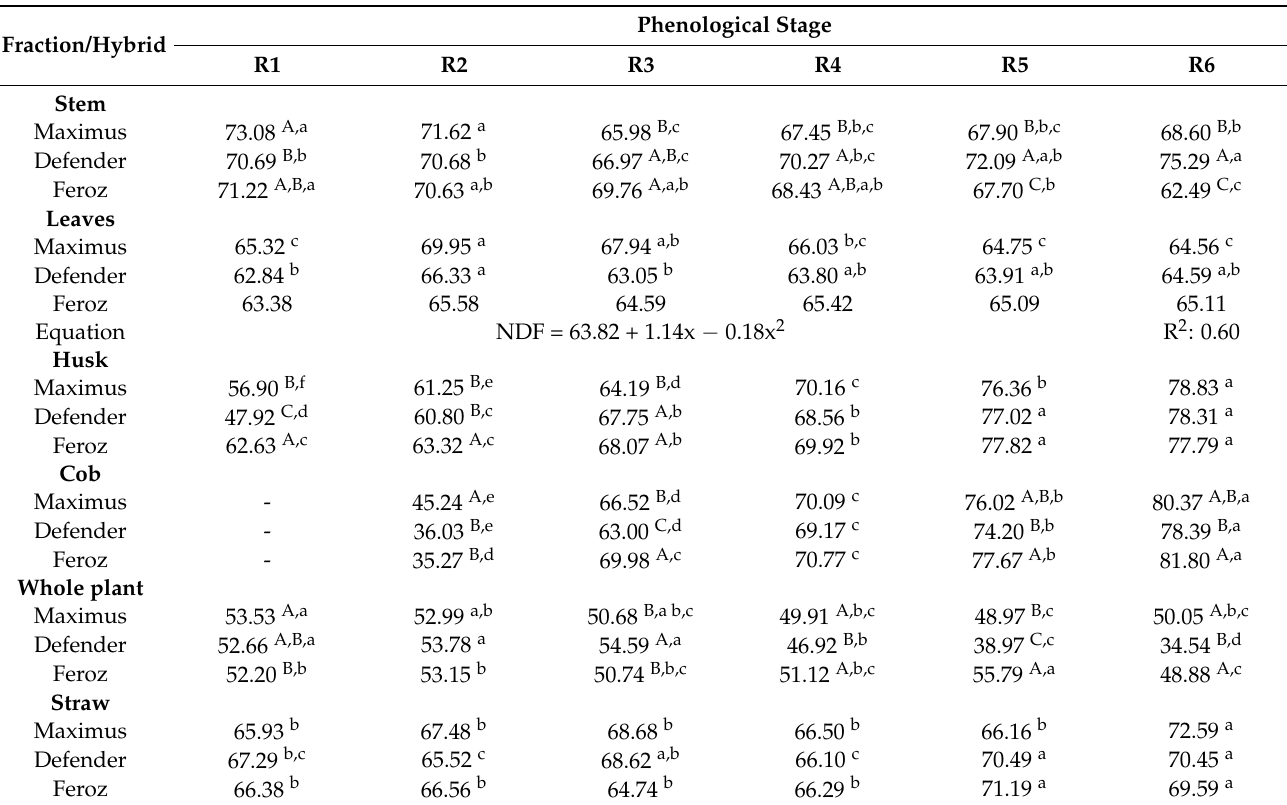
Table 3. Neutral detergent fiber (% DM) of the whole plant and the fractions of three maize hybrids harvested at the beginning of the six reproductive stages of